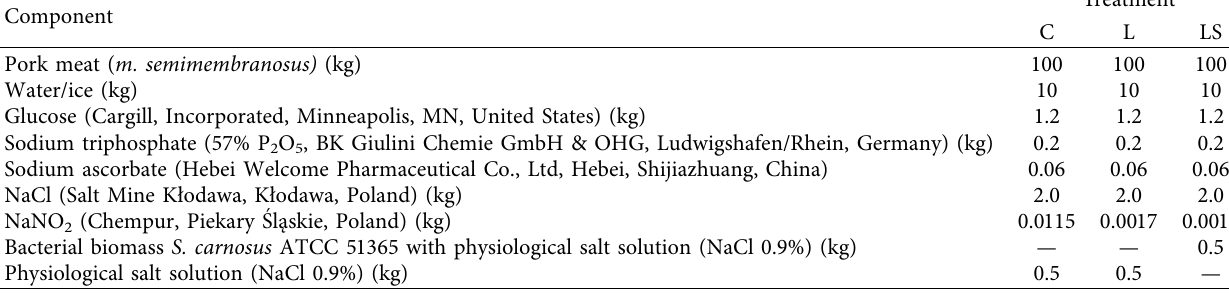
Table 1: Formula of model meat